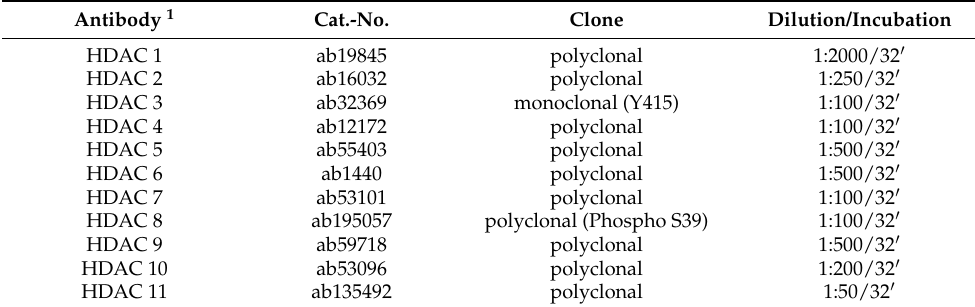
Table 1. Immunohistochemistry